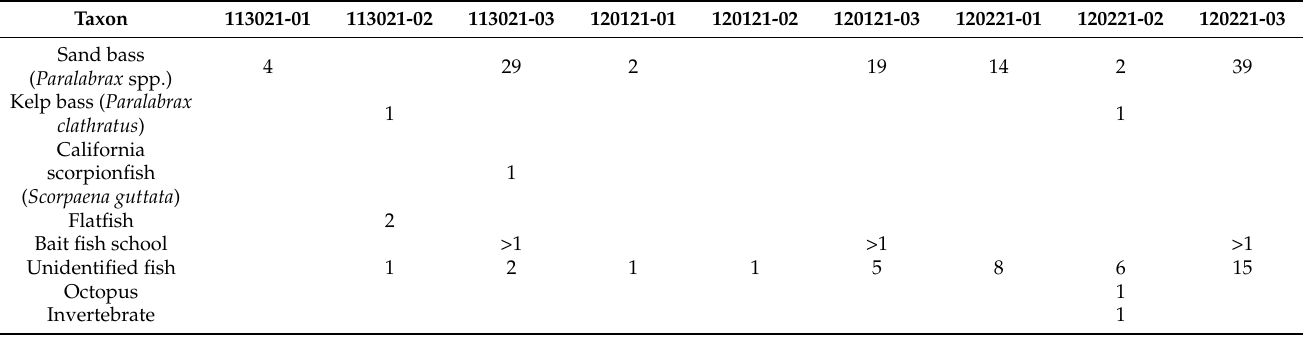
Table 2. Occurrences of each taxon in the nine video deployments, identified by their drop